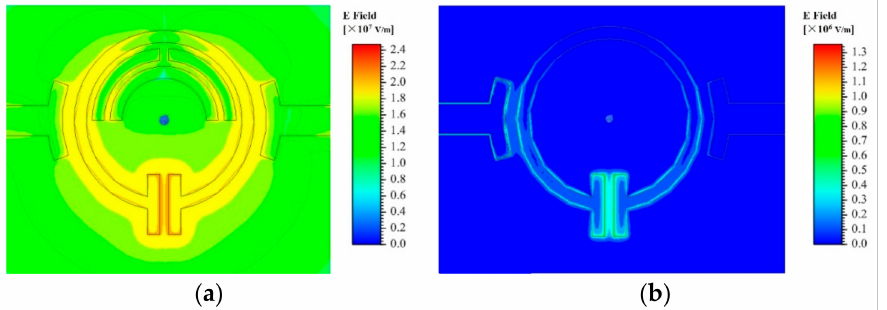
Figure 2. Electric distribution of SRR structure ( a ) with inner metal rings and ( b ) without inner metal rings.